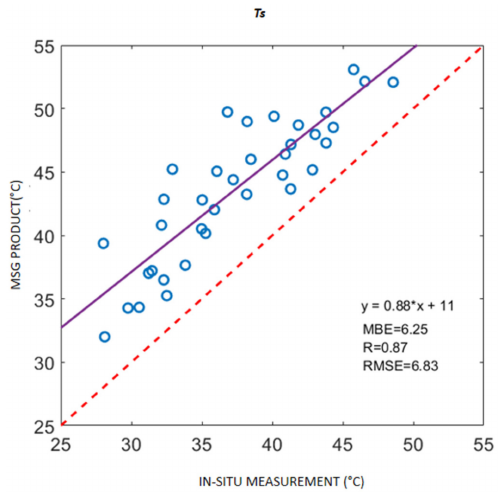
Figure 6. Scatterplot of MODIS versus MSG SEVIRI